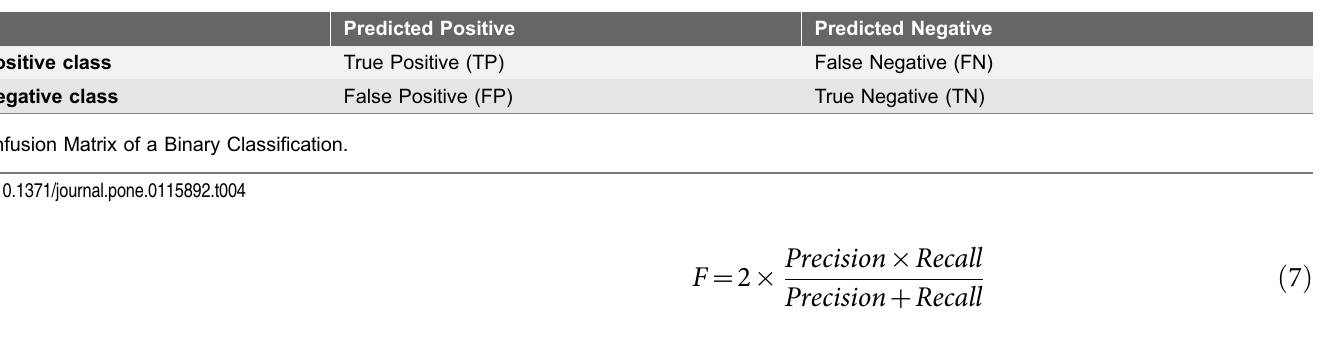
Table 4. mycoSet Confusion